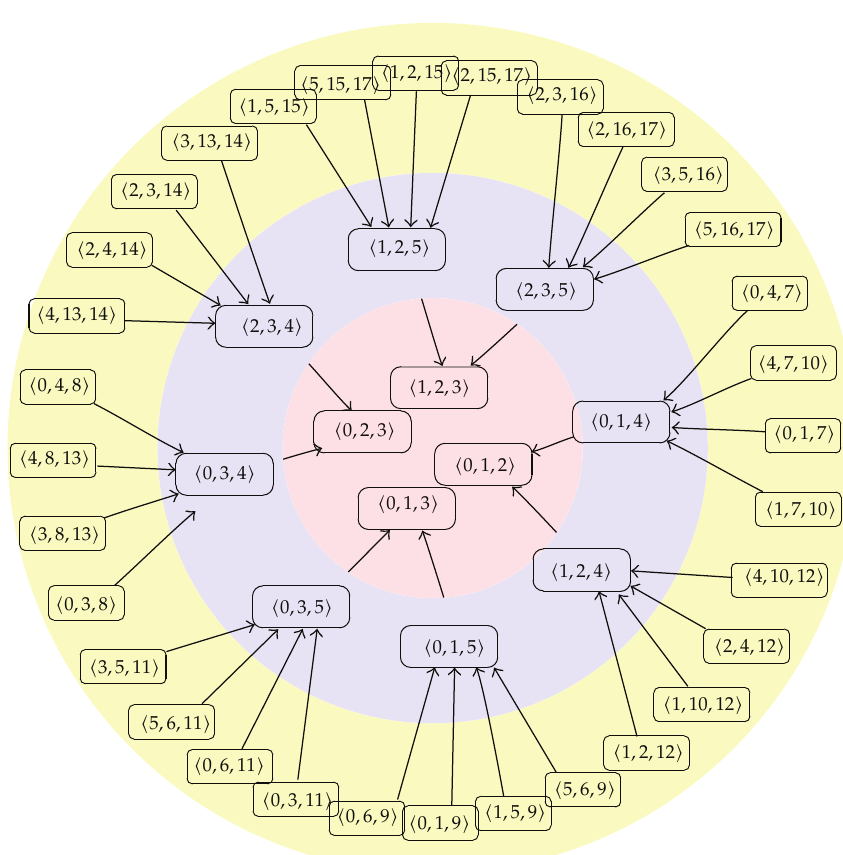
(cid:2) yellow, outer circle (cid:3) , Σ (cid:2) blue (cid:3) , and Σ (cid:2) red, inner circle (cid:3) . By B B B